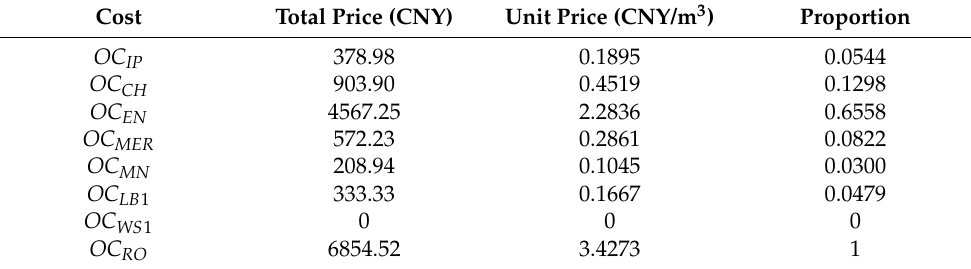
Table 14. SWRO system cost ratio table.